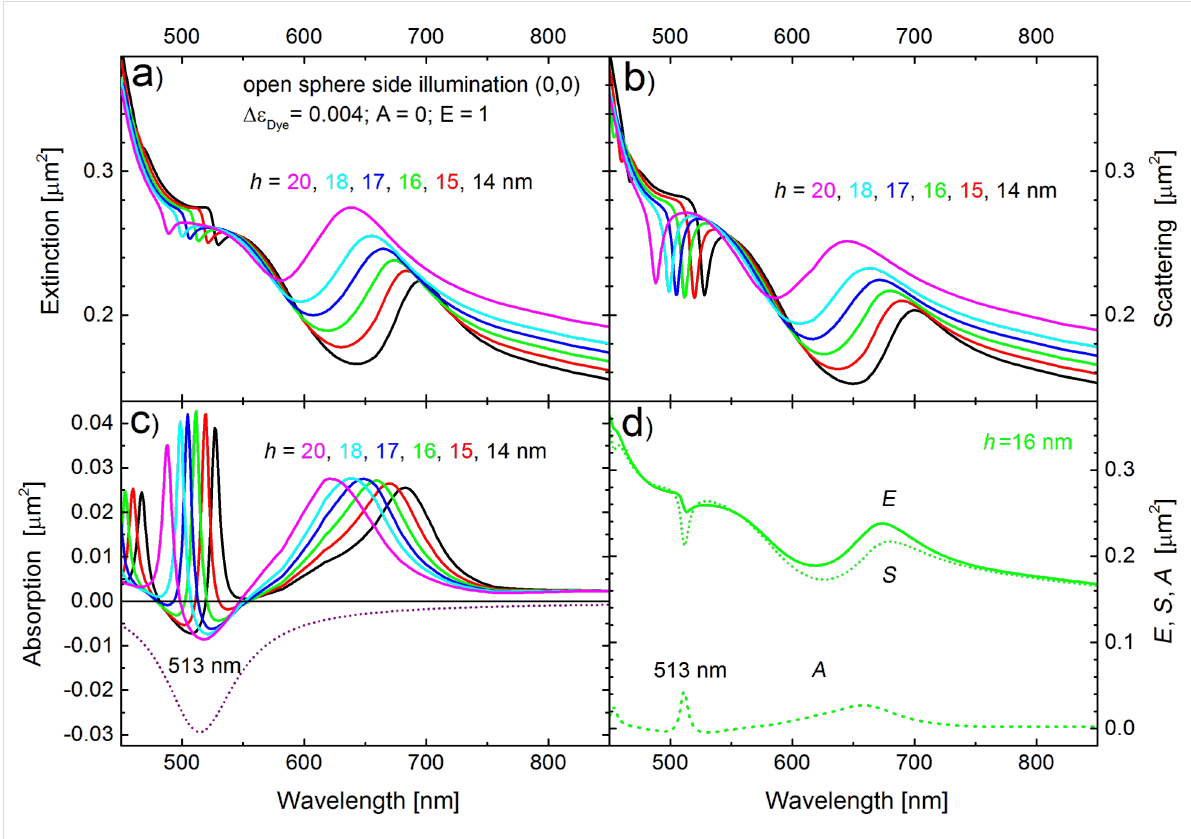
Figure 5: Fine-tuning of the Ag semi-shell resonances to the emission band of the dye. Parameters and the organization of panels a–d are the same as in Figure 2 apart from the thickness h , color coded in the plots, and ε Sphere from Equation 1, which now includes dye molecules. Dimensionless values of Im( ε Sphere ) are shown in panel (c) by a dotted